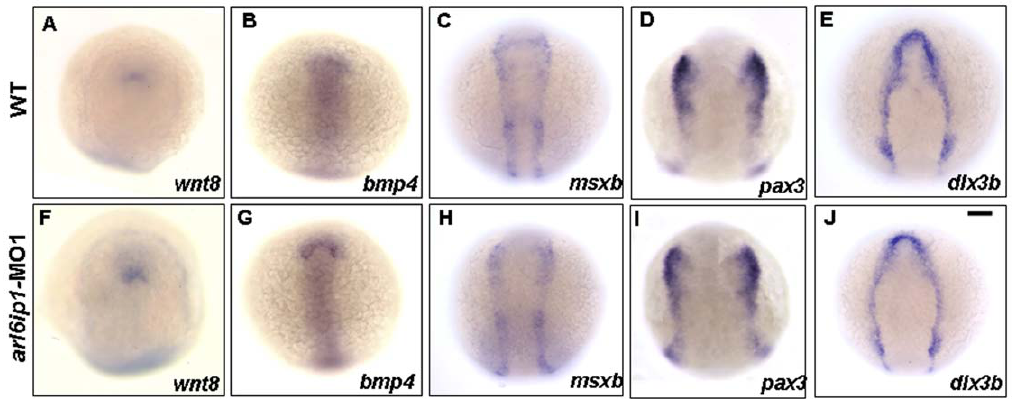
Figure 4. Expressions of ectodermal patterning factors appear normal in arl6ip1 -MO1-injected embryos. Dorsal views of wild-type (A–E) and arl6ip1 morphant (F–J) embryos at the 3-somite stage. Anterior to the top. The neural ectodermal patterning factors of wnt8 (A, F), bmp4 (B, G), msxb (C, H), dlx3b (D, I), and pax3 (E, J). Normal expressions of these genes reveal that ectodermal patterning factors are not affected in arl6ip1 morphants, suggesting that Arl6ip1 does not have a role in ectodermal patterning. Scale bar: 100 m